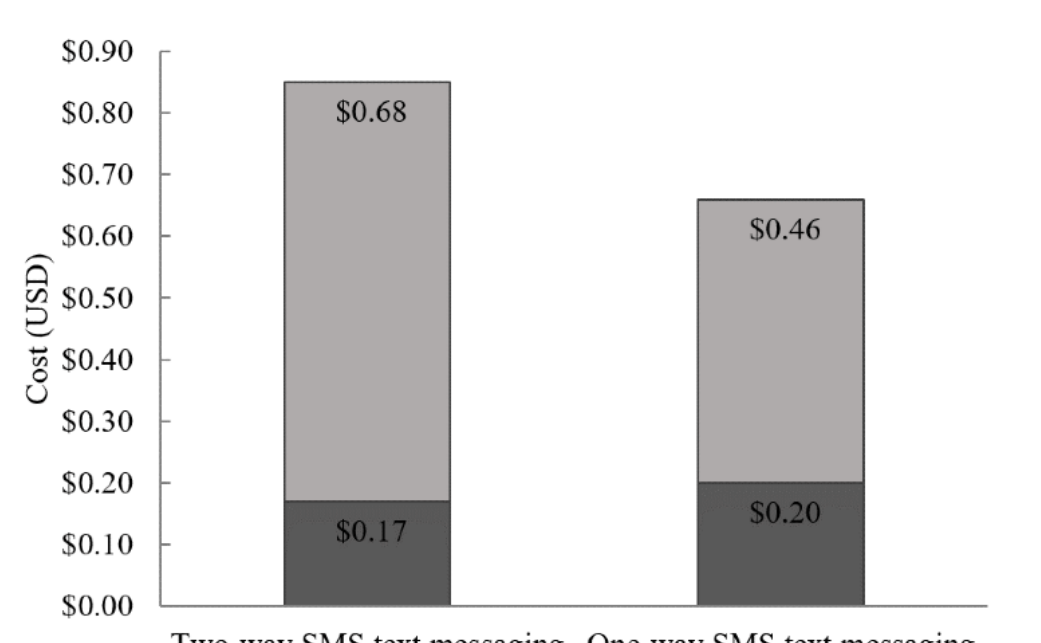
Figure 3. Cost per contact by fixed and variable